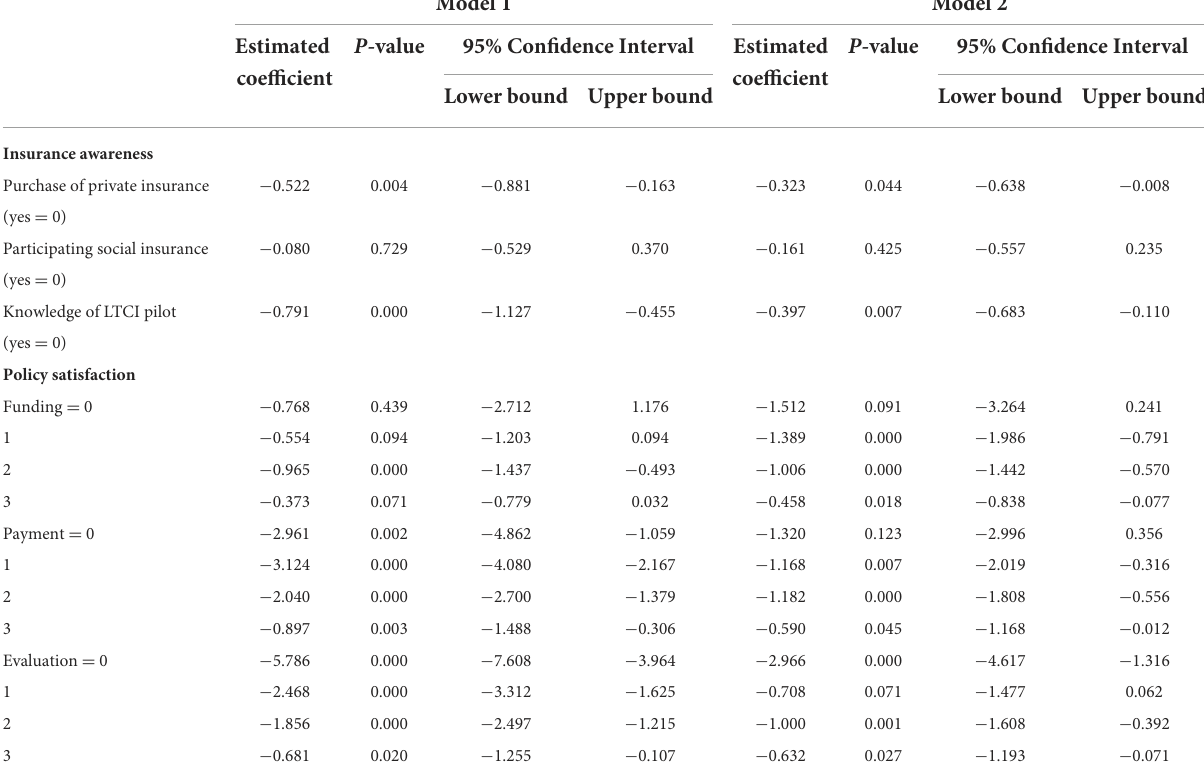
TABLE 3 Analysis of factors associated with trust in the long-term care insurance system by ordinal logistic